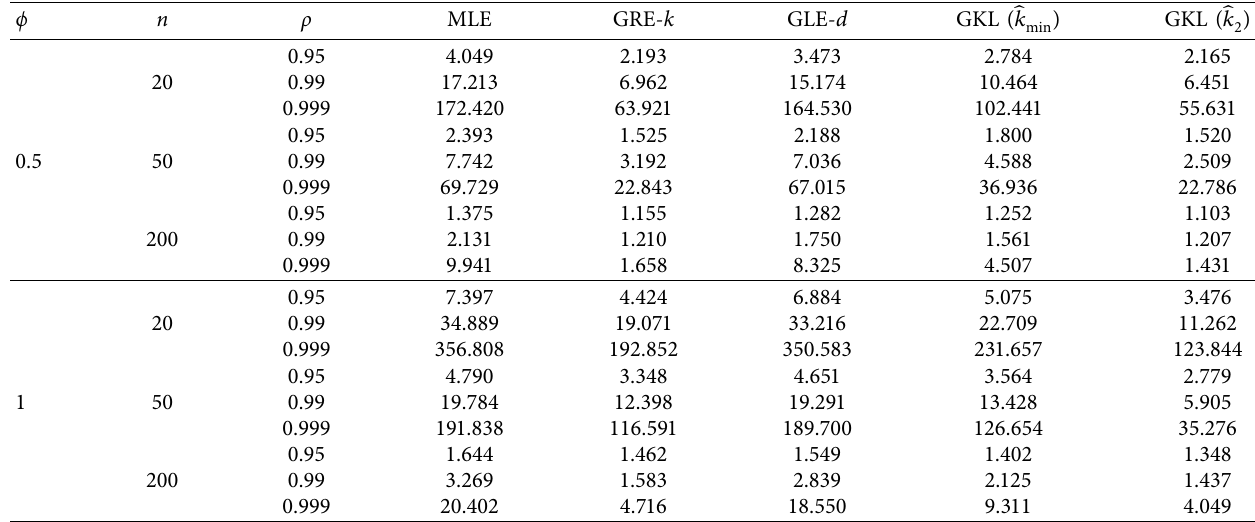
Table 2: Estimated mean squared error when p